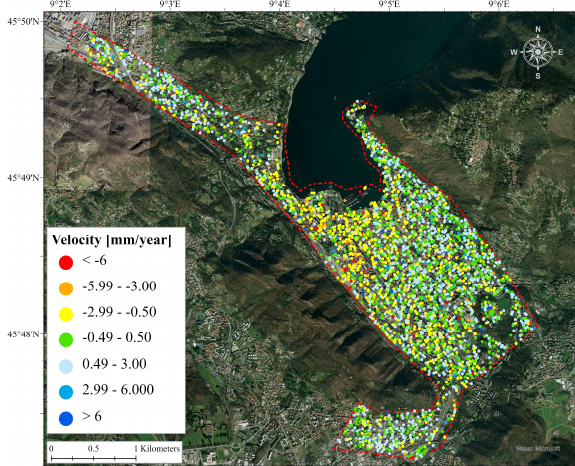
Figure 5. InSAR-derived vertical displacement velocity related to period 1997-2204 using SAR images in Descending